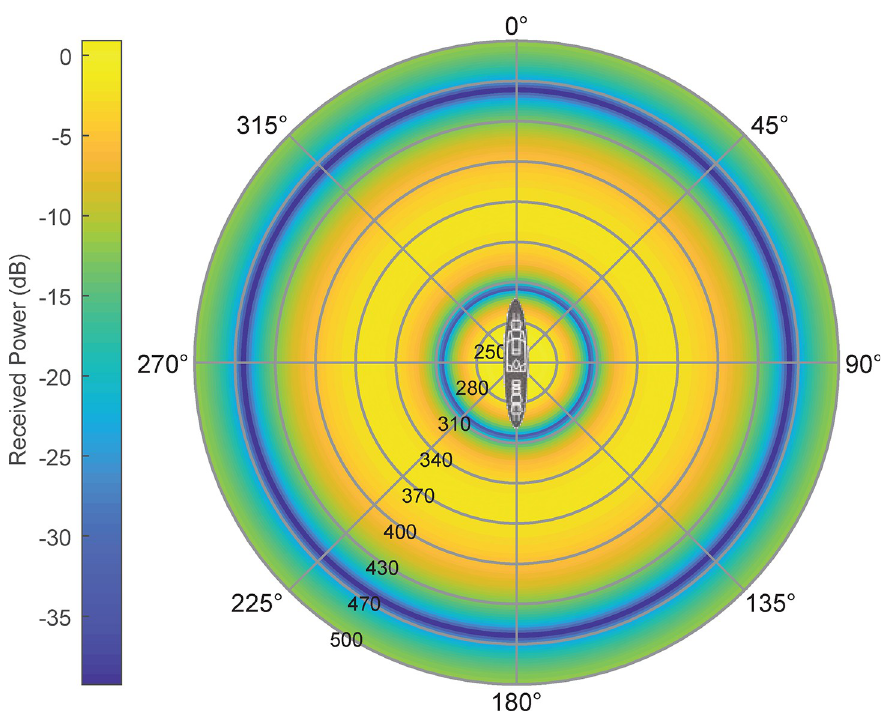
Fig 16. Multipath scenario for f = 300 MHz, h UAV = h AUT = 21.5 m. https://doi.org/10.1371/journal.pone.0245004.g016 Table 5 summarizes distance and flight levels for the frequency bands mentioned. Assum- ing multipath effect for VHF, UHF, and SHF, radiation pattern margin errors for these bands is also considered, assuming the uncertainty due to this issue: